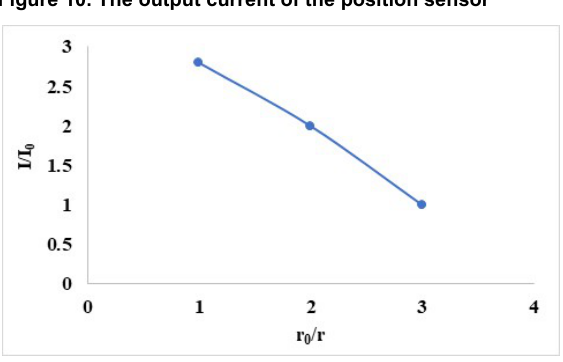
-0.8 Figure 10. The output current of the position sensor